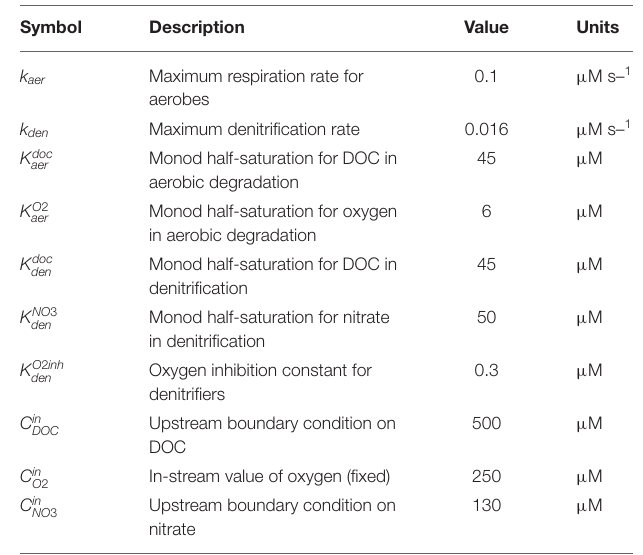
TABLE 1 | Reference case reaction parameters.